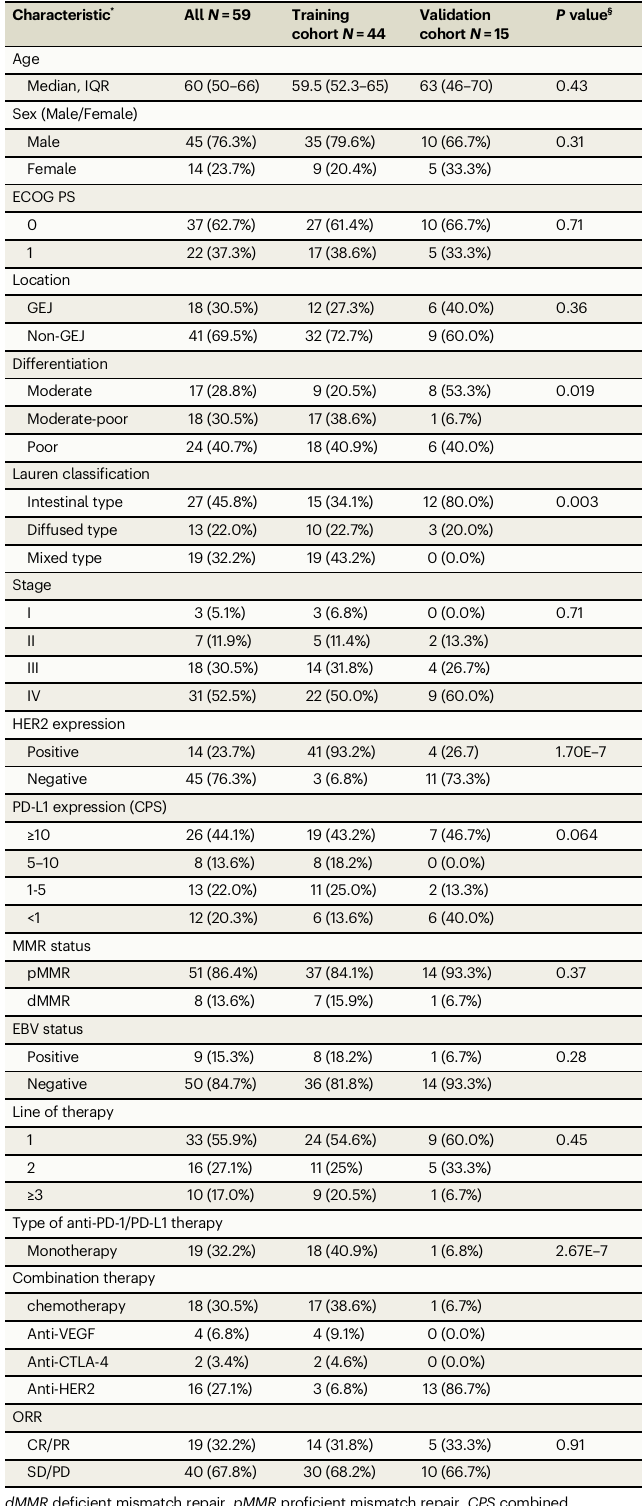
Table 2 | Baseline characteristics of 59 gastric cancer patients who received immunotherapy in the training cohort and validation